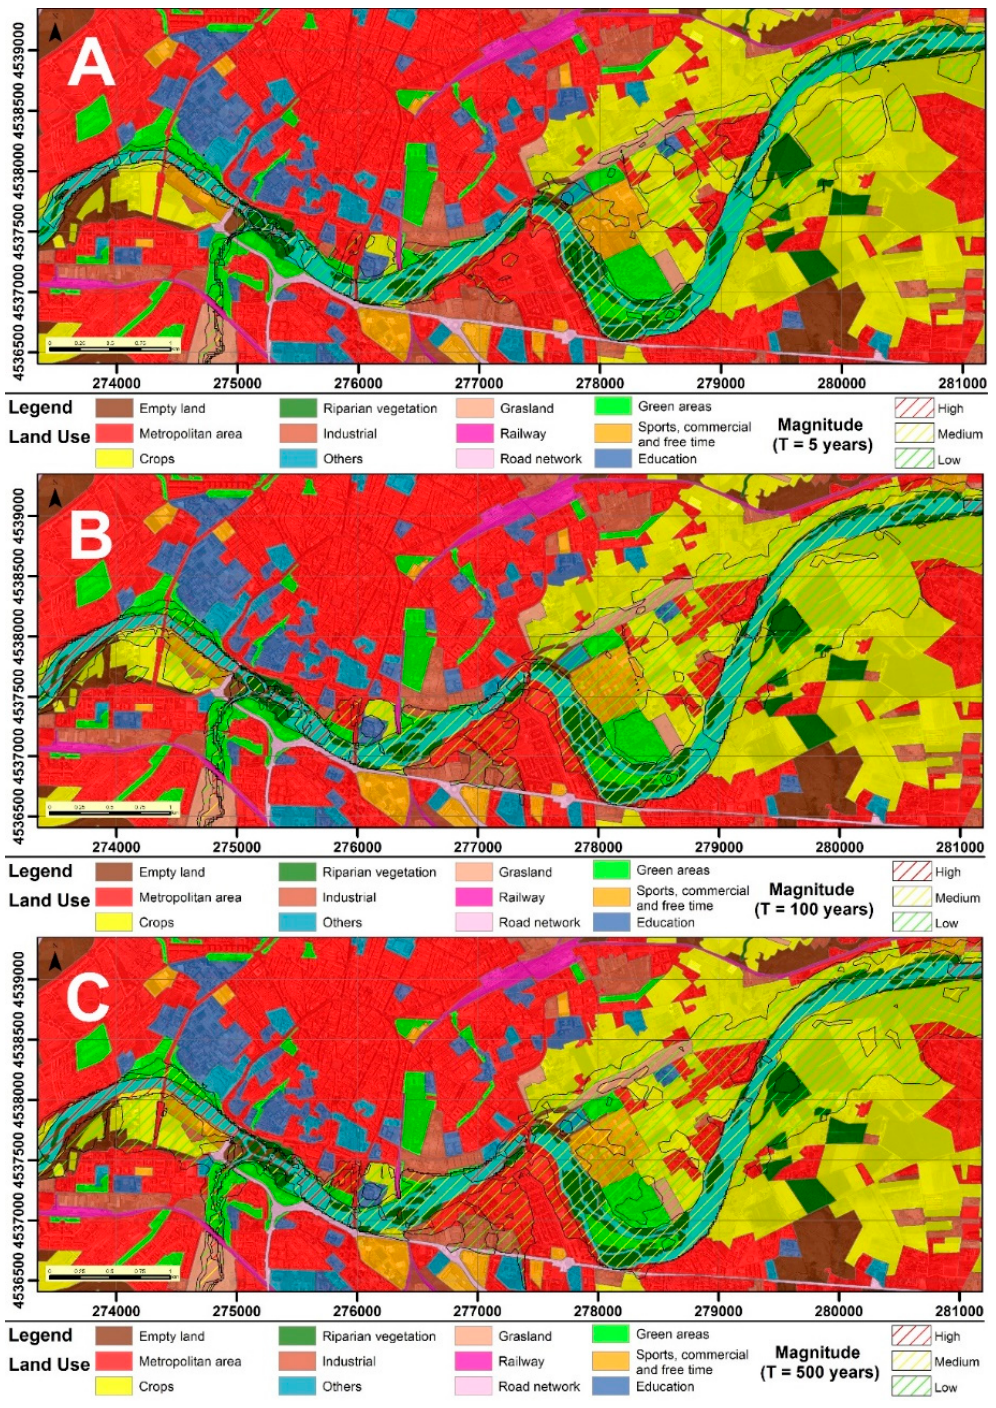
Figure 7. Flooded areas in each scenario according to their land use: ( A ) T = 5 years; ( B ) T = 100 years; and ( C ) T = 500 years.